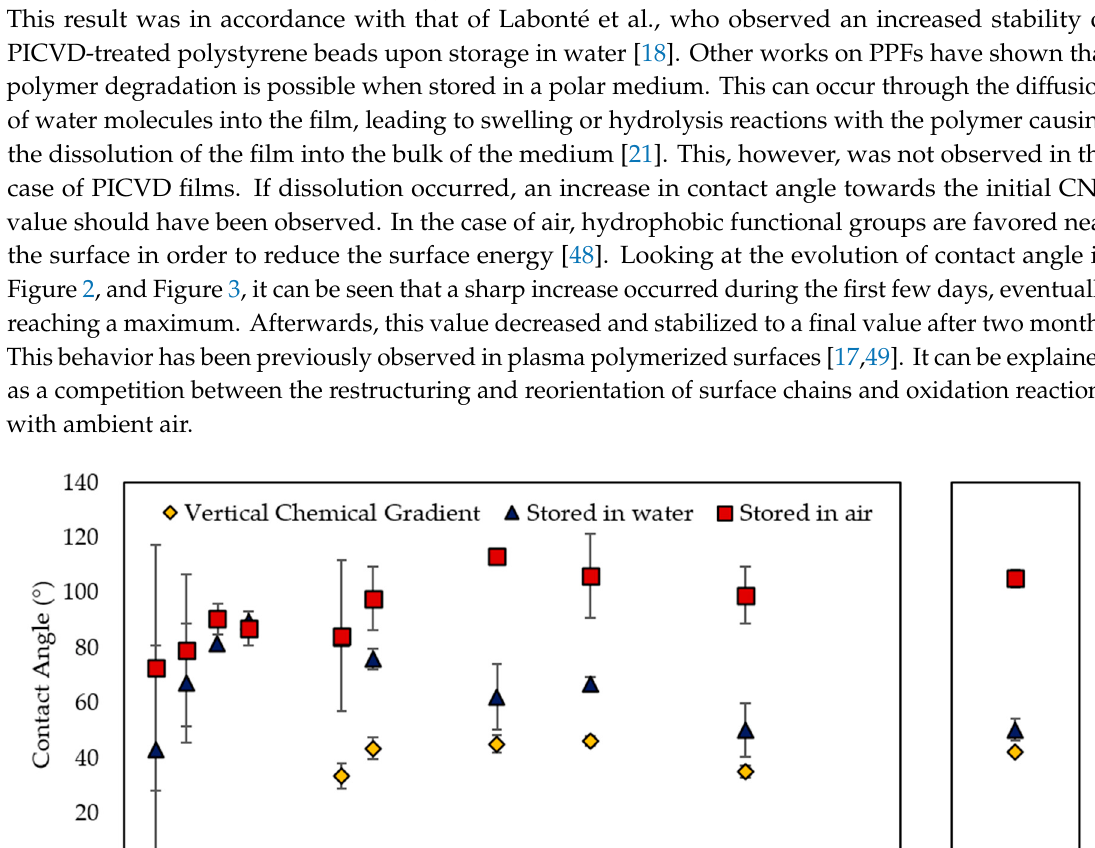
Table 3. Water contact angle after 2 months. SS-CNT: carbon nanotube forest on stainless steel grids.